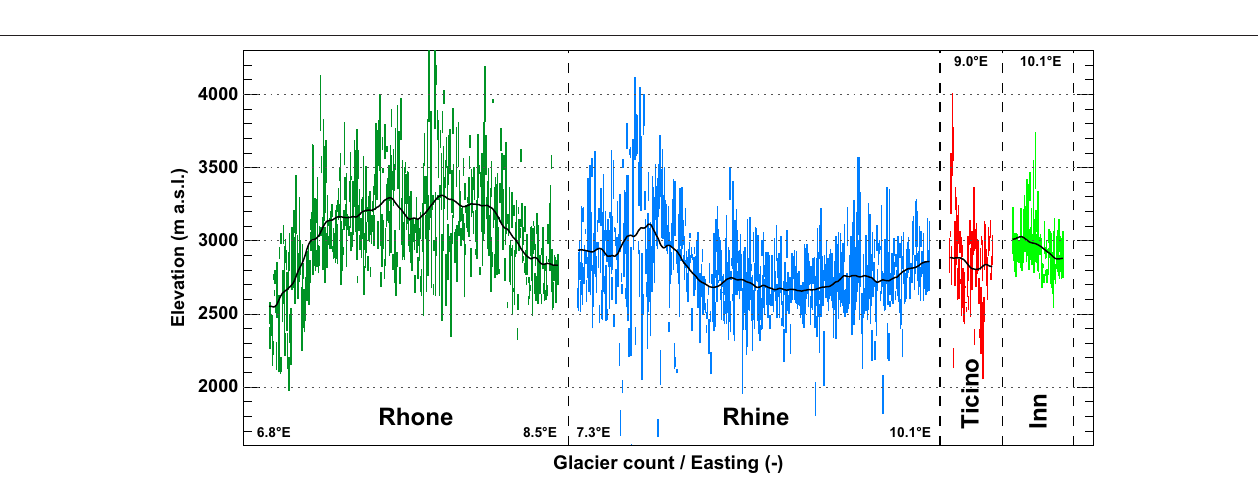
FIGURE 2 | Elevation ranges (bars) of very small glaciers in Switzerland sorted according to Easting within the major hydrological basins (Figure 1). The solid line corresponds to a running mean.